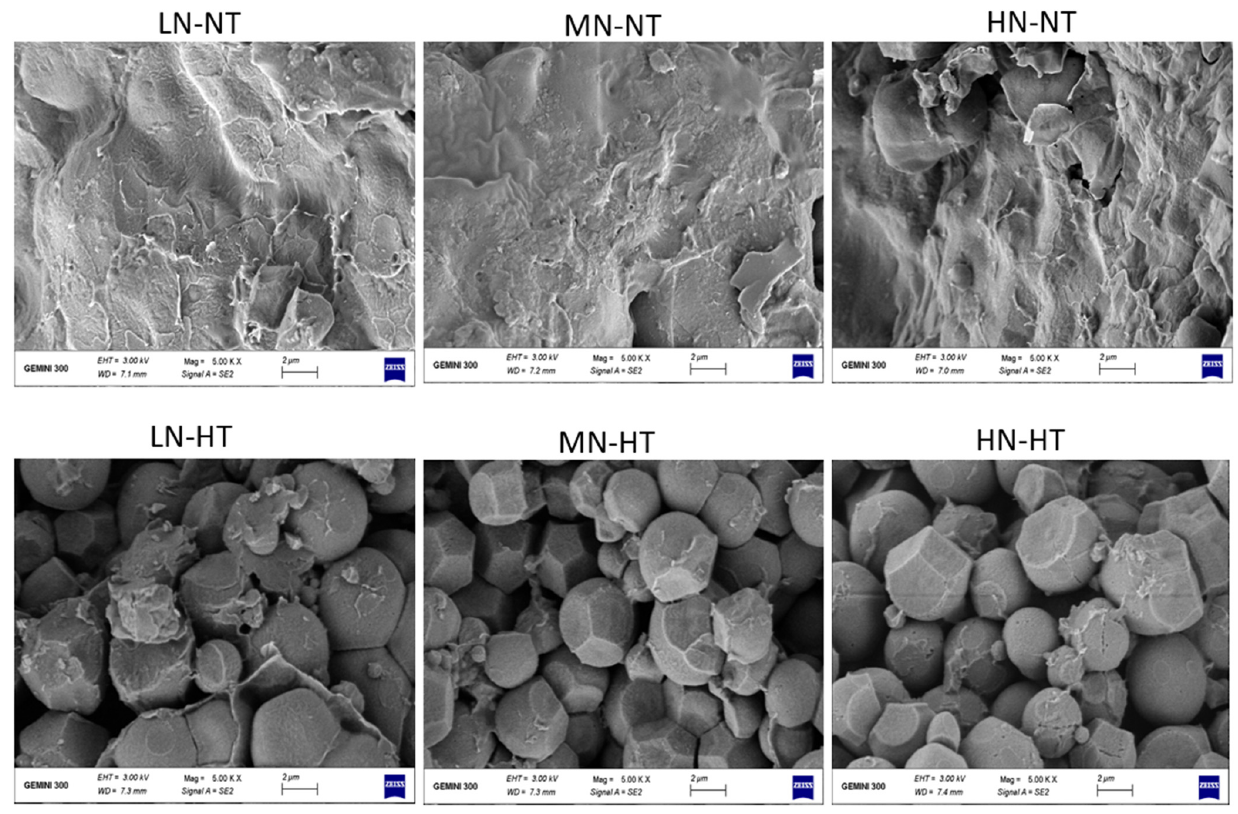
FIGURE 1 | Comparison of starch granule morphology for six treatments by using SEM. LN-NT, MN-NT, HN-NT, LN-HT, MN-NT, and HN-HT indicate low nitrogen-normal temperature, moderate nitrogen-normal temperature, high nitrogen-normal temperature, low nitrogen-high temperature, moderate nitrogen-high temperature, and high nitrogen-high temperature,